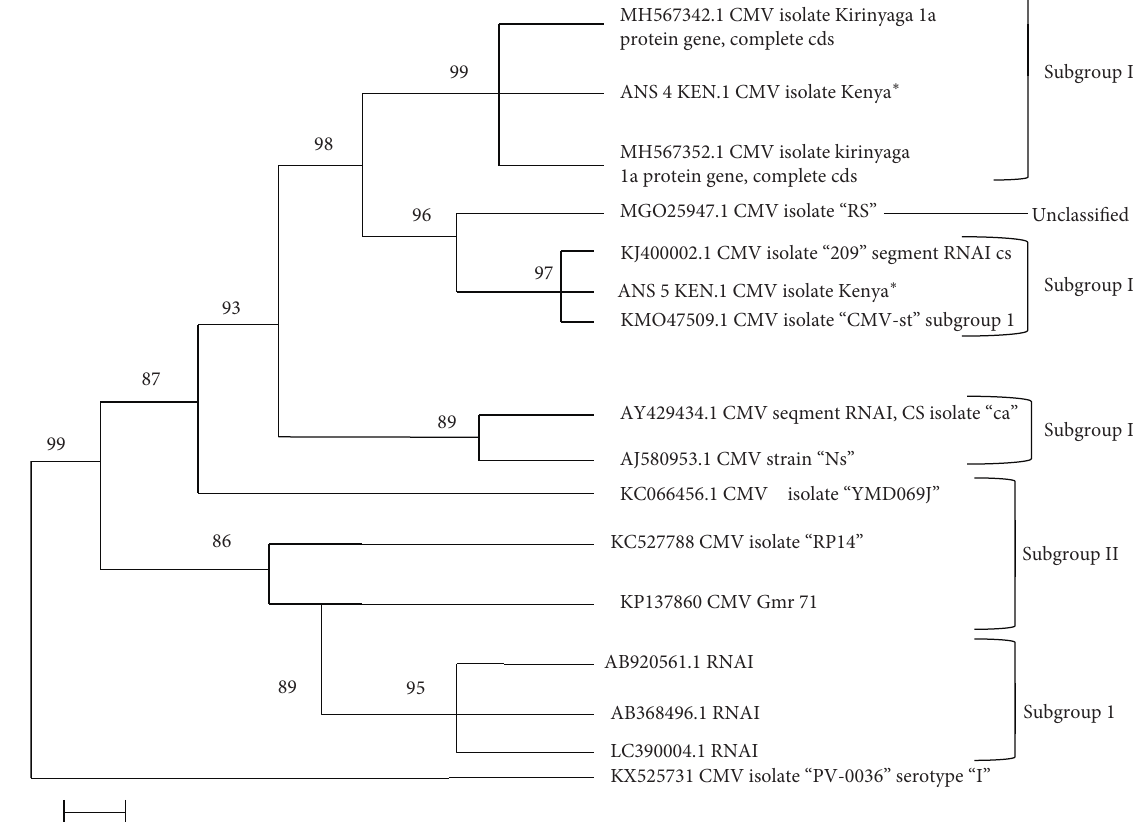
Figure 3: Phylogenetic analysis of Cucumber mosaic virus (CMV) isolates, with aligned nucleotide sequences, generated using the neighbor- joining method and MEGA6 software. The percentage of replicate trees in which the associated taxa clustered together in the bootstrap test (1000 replicates) is shown next to the branches. ∗ Kenyan ANS isolates. The tree was rooted using KX525731 CMV Isolate “PV-0036” serotype “I” as an outgroup sequence for the phylogenetic analysis.